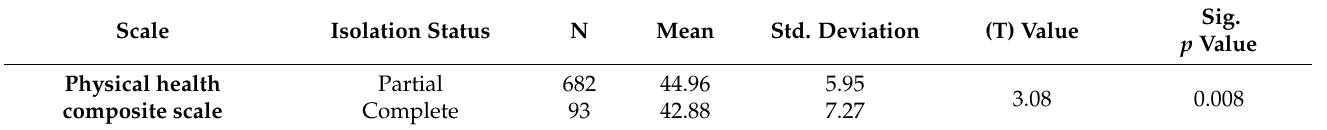
Table 3. Statistical differences between participants’ isolation statuses and physical health (N = 775).